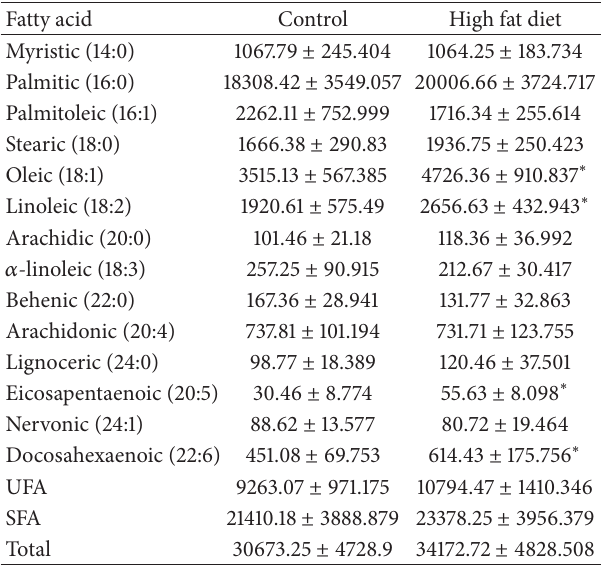
Table 2: Phospholipids composition in the parotid salivary glands (nmol/g). Fatty acid Control High fat